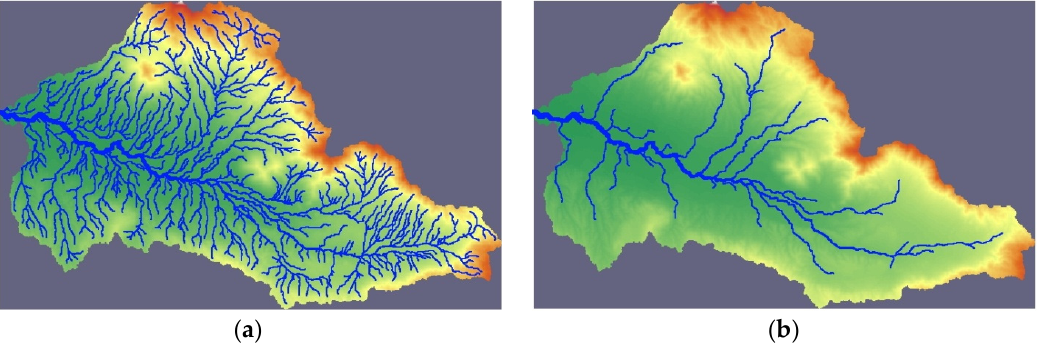
Figure 5. ( a ) Low threshold—dense network; and ( b ) high threshold—sparse network.